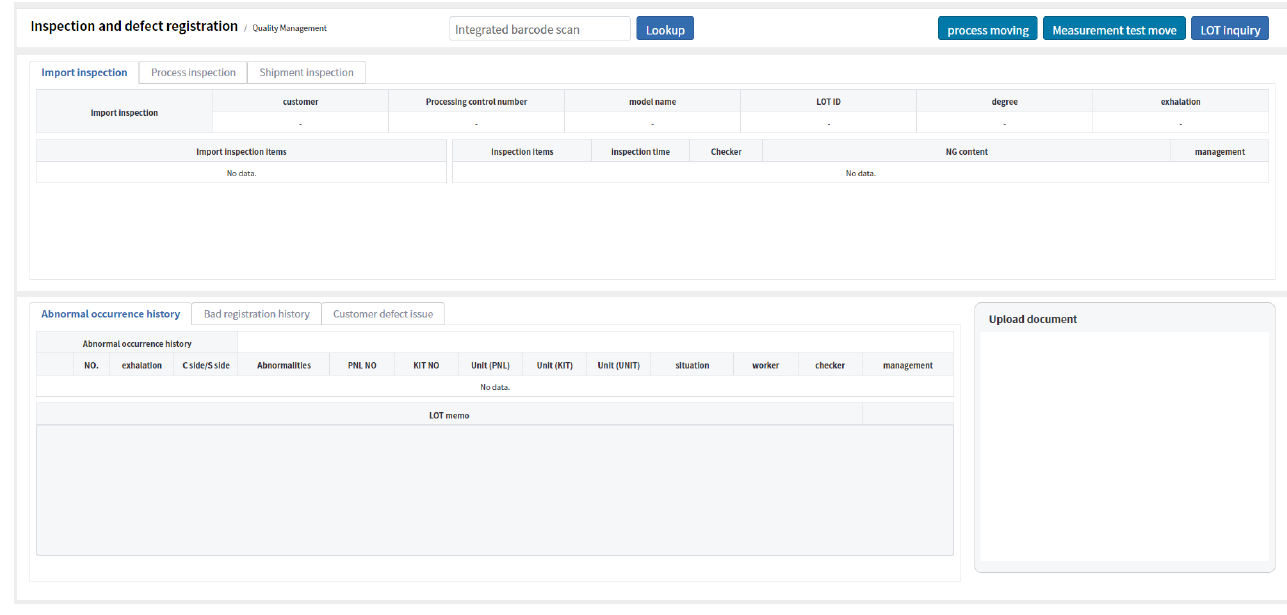
Figure 15. The status of a process